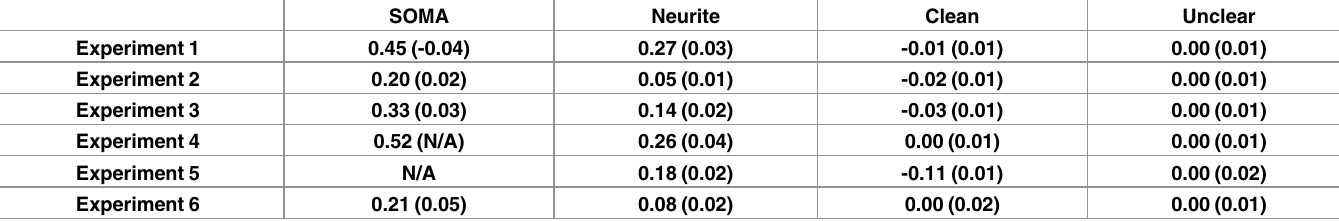
Table 1. The averagechange in resistance (M Ω )of each classified electrode after background subtraction for all six experiments (SEM in brackets).